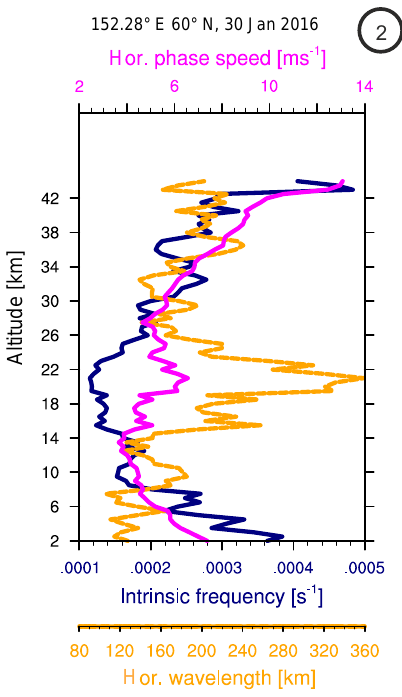
Figure 6. Intrinsic frequency (bold, dark blue), horizontal wave- length (dashed, orange), and horizontal phase speed (bold, pink) for profile (2) (Fig.